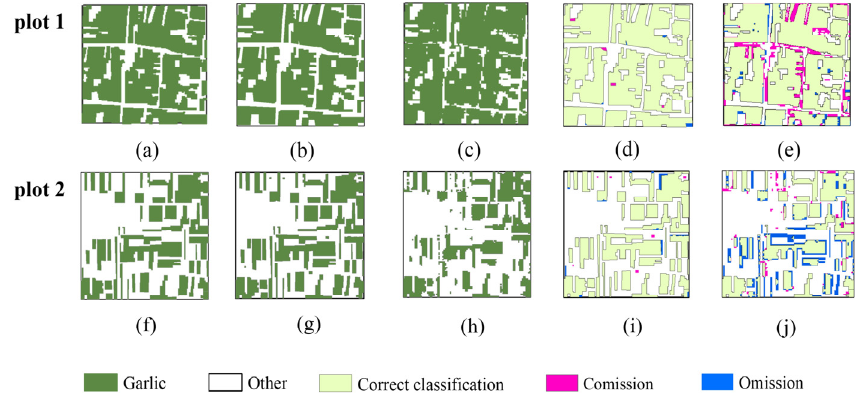
Figure 12. Results of accuracy validation based on two validation quadrats with an area of 1 km by 1 km. ( a , f ) The ground truth quadrats. ( b , g ) The extraction results in optimal multi-temporal scheme. ( c , h ) The garlic extraction results in optimal mono-temporal scheme. ( d , i ) Accuracy valida- tion results in optimal multi-temporal scheme. ( e , j ) Accuracy validation results in optimal mono- temporal scheme.